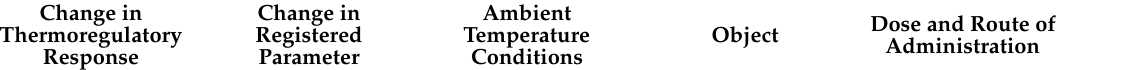
Table 3. Effect of 5-HT 1A receptor activation by its selective agonist 8-OH-DPAT on thermoregulatory responses in warm-blooded